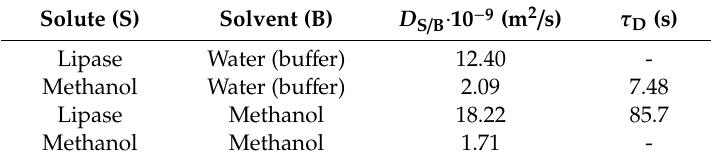
Table 2. Estimated diffusivities and average diffusion time for methanol and lipase at 40 °C.